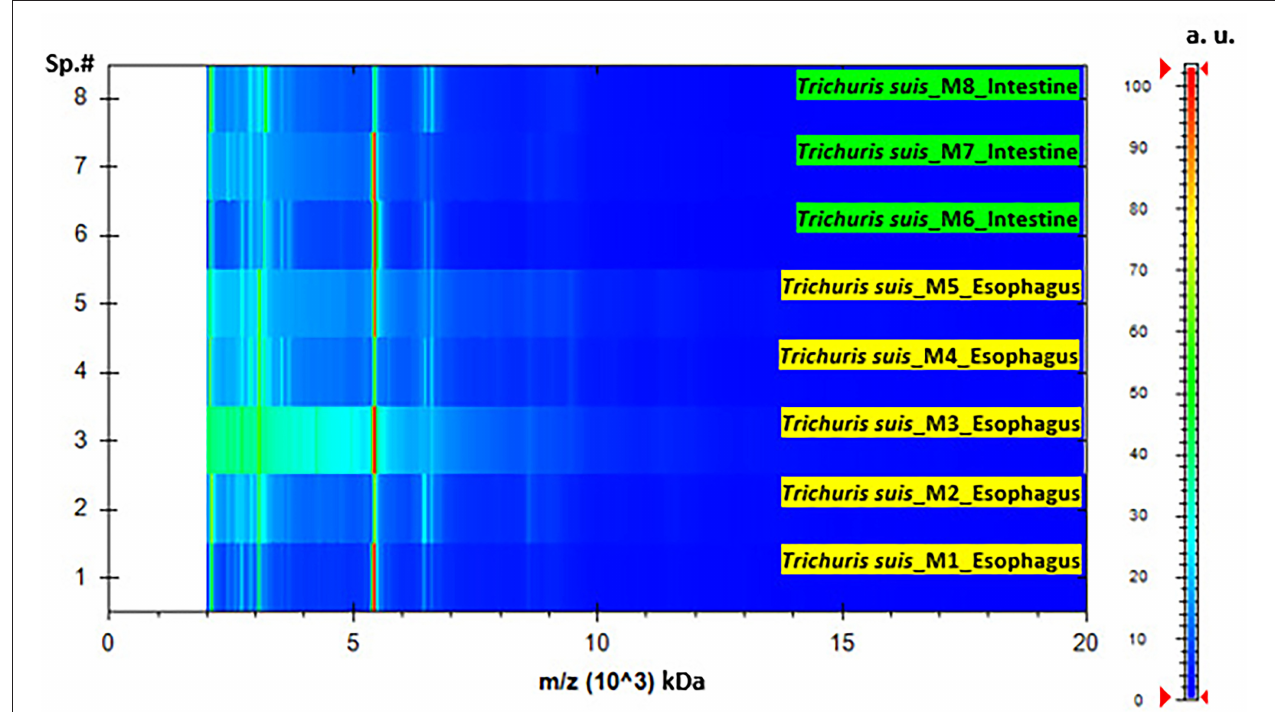
FIGURE 2 | Pseudo-gel representing the protein profile obtained after MALDI-TOF MS analysis of T. suis specimens’ representative of esophagus and intestine samples. On the x -axis, the mass-to-charge values ( m / z , kDa) are reported, at the same time, on the right y -axis, the scale bar reveal the relationship between the color intensity and the peak intensity, expressed by arbitrary units (a.u.). The spectra samples are represented on the left y -axis (Sp.#).